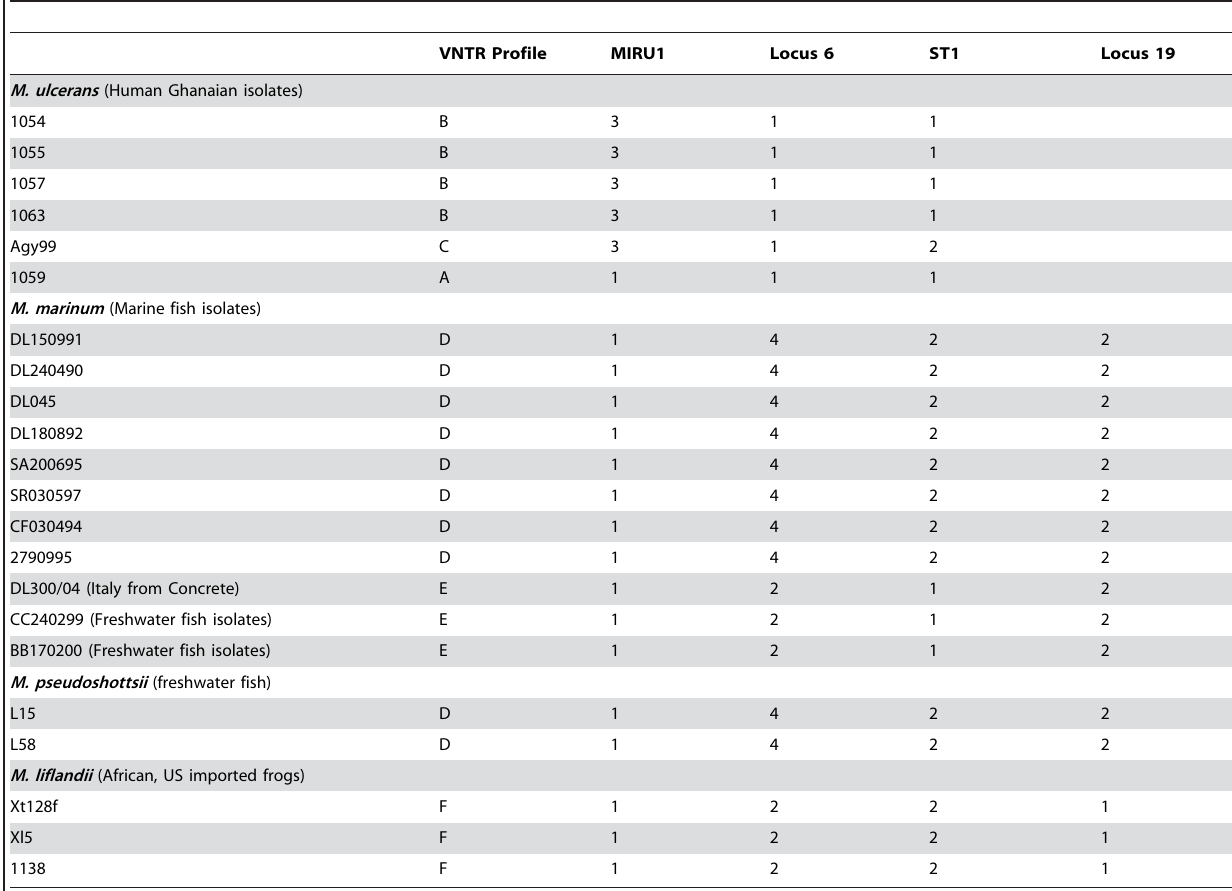
Table 5. VNTR profiles of M. ulcerans and other MPM isolates based upon numbers of repeats found at different loci (MIRU1, locus 6, ST1, and Locus 19 when